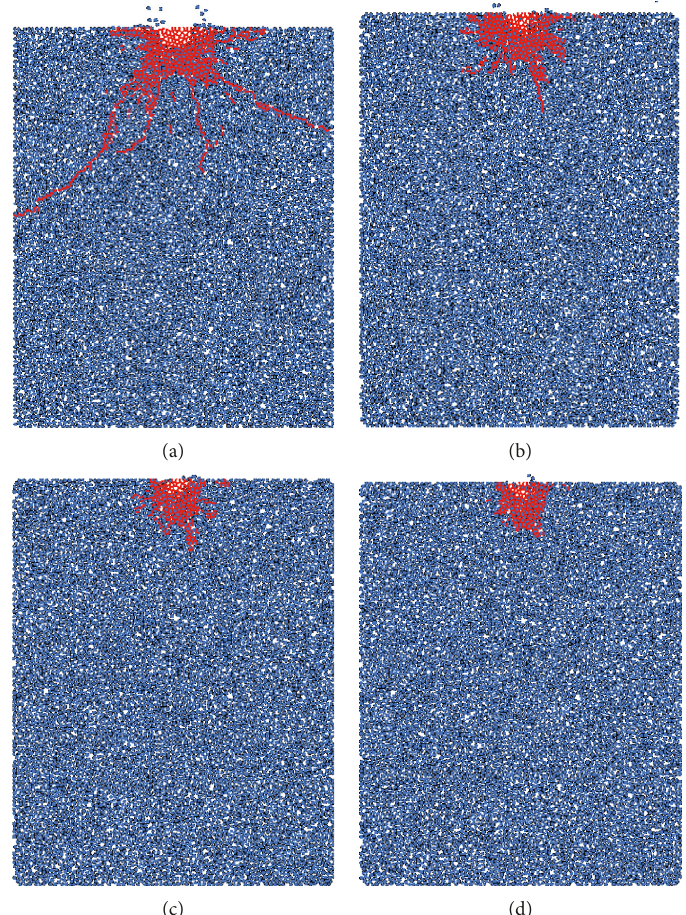
Figure 11: Breaking state of electropulses inside granite at 100 μ s under confining pressures of (a) 0MPa; (b) 12MPa; (c) 23MPa; and (d)